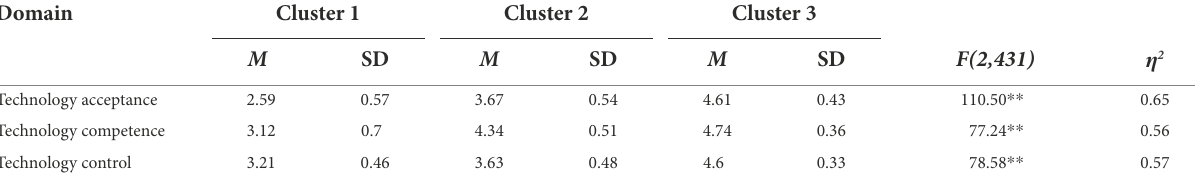
TABLE 2 One-way ANOVA of the technology readiness scales between profiles.